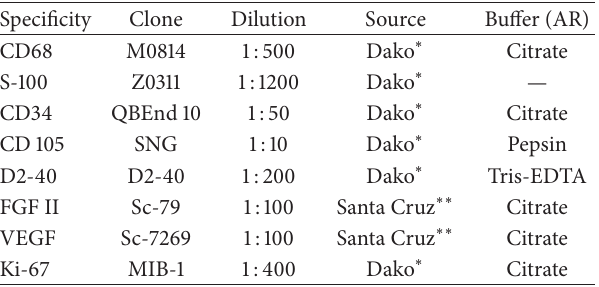
Table 1: Details of the antibodies used for